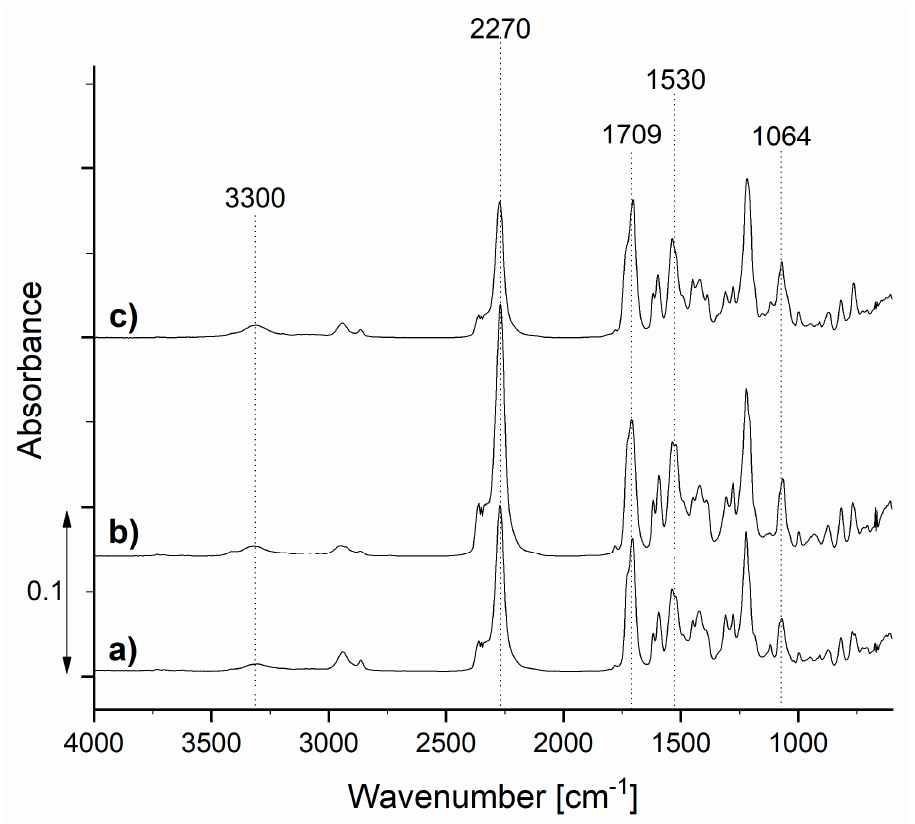
Figure 5. FTIR spectra of the synthesized prepolymers TDIprep_G ( a ), TDIprep_H ( b ), and TDIprep_B ( c ).